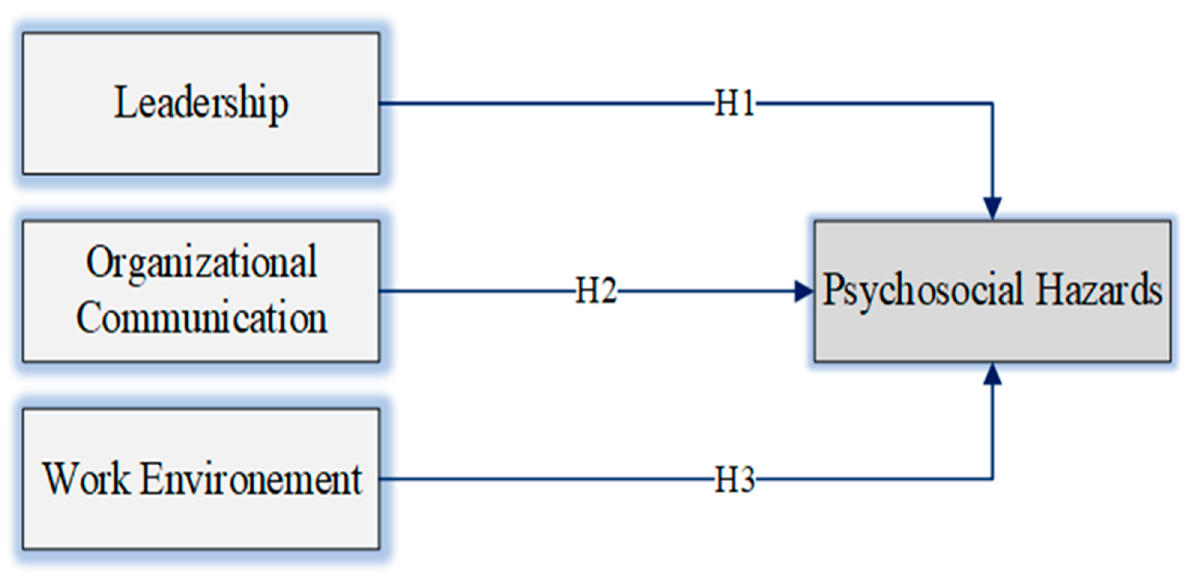
Figure 1. Conceptual